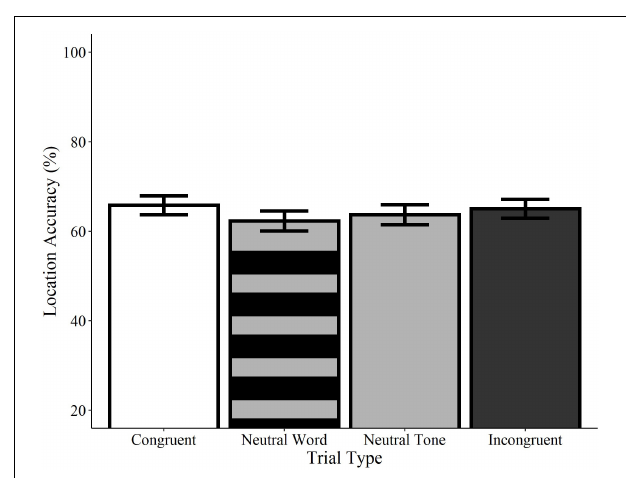
FIGURE 5 | Effect of trial type on location accuracy for spoken words. Location accuracy did not differ between congruent (white), neutral word (striped gray), neutral tone (solid gray), and incongruent (black) spoken word trials. Error bars represent standard error.